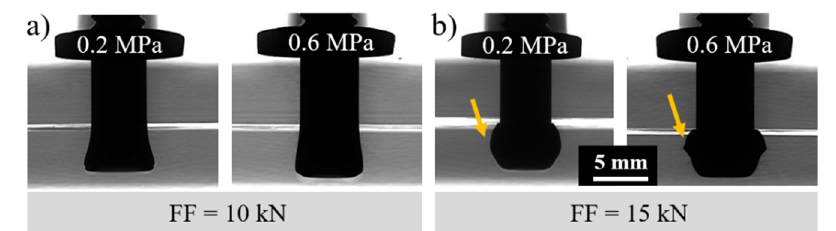
Figure 12. X-ray micro-computed tomography analysis of the joints produced with ( a ) low (10 kN) and ( b ) high (15 kN) friction forces, as well as the influence of clamping pressure on the rivet tip shape. (Joining condition—RS: 15,000 rpm, DF: 7.5 mm).